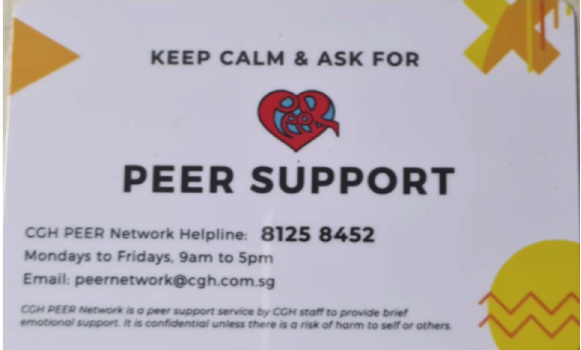
Various methods for healthcare staff to seek Fig. 4: psychological